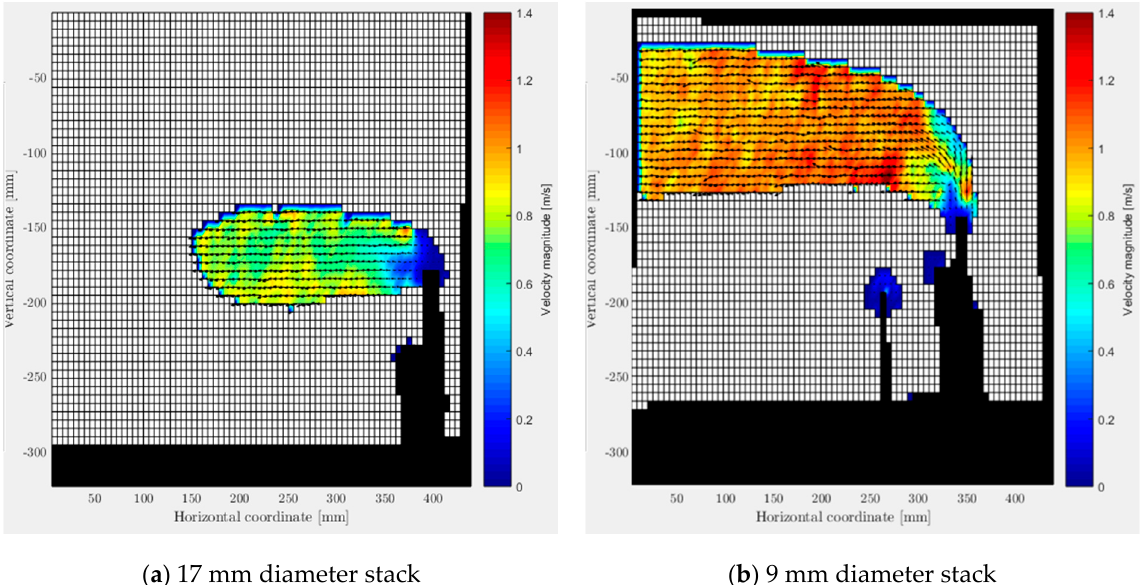
Figure 9. Wind velocity field results for a stack diameter of ( a ) 17 mm and ( b ) 9 mm to evaluate the effects on the exhaust smoke dispersion (for an inflow condition of 1 m.s − 1 and a North-Easterly wind direction).